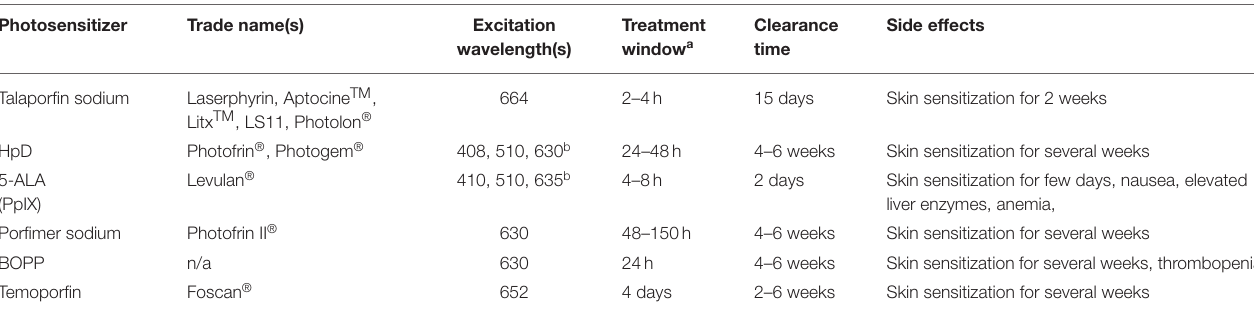
TABLE 1 | Properties of clinically relevant photosensitizers.